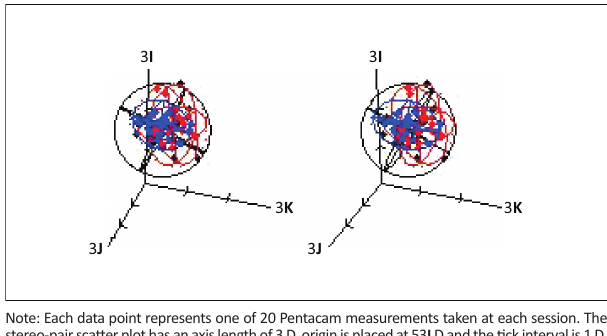
Note: Each data point represents one of 20 Pentacam measurements taken at each session. The stereo-pair scatter plot has an axis length of 3 D, origin is placed at 53 I D and the tick interval is 1 D. FIGURE 3: Stereo-pair scatter plot with included 95 % distribution ellipsoids for measurements taken of the posterior corneal surface for session one (black data points), session two (red data points) and session three (blue data points). axes by 90° for a view down the stigmatic axis (Figures 2a, c, e and 4a, c, e) and by 180° degrees for a view down the oblique antistigmatic axis (Figures 2b, d, f and 4b, d, f). This